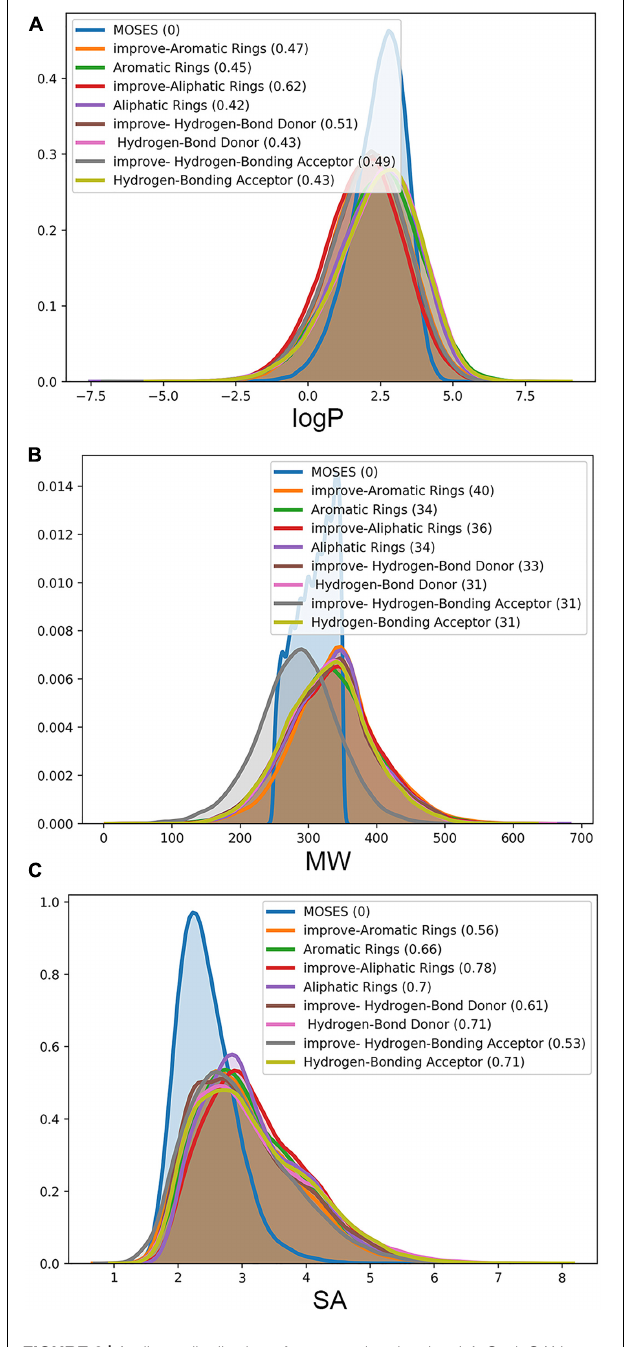
FIGURE 6 | Attribute distribution of generated molecules. LA-CycleGAN model provides (A) the improved logP, (B) molecule weight (MW) and (C) Synthetics Accessibility (SA)